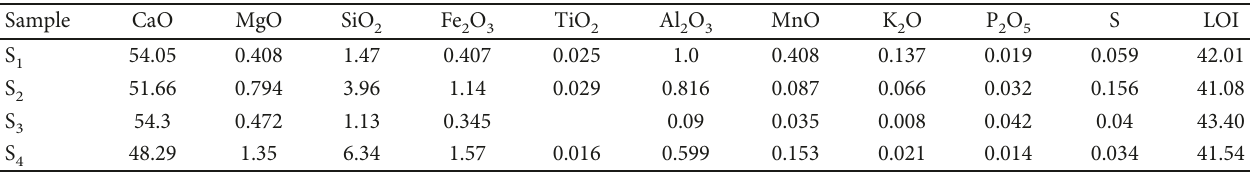
Table 2: Chemical composition of the carbonate samples. Major oxides